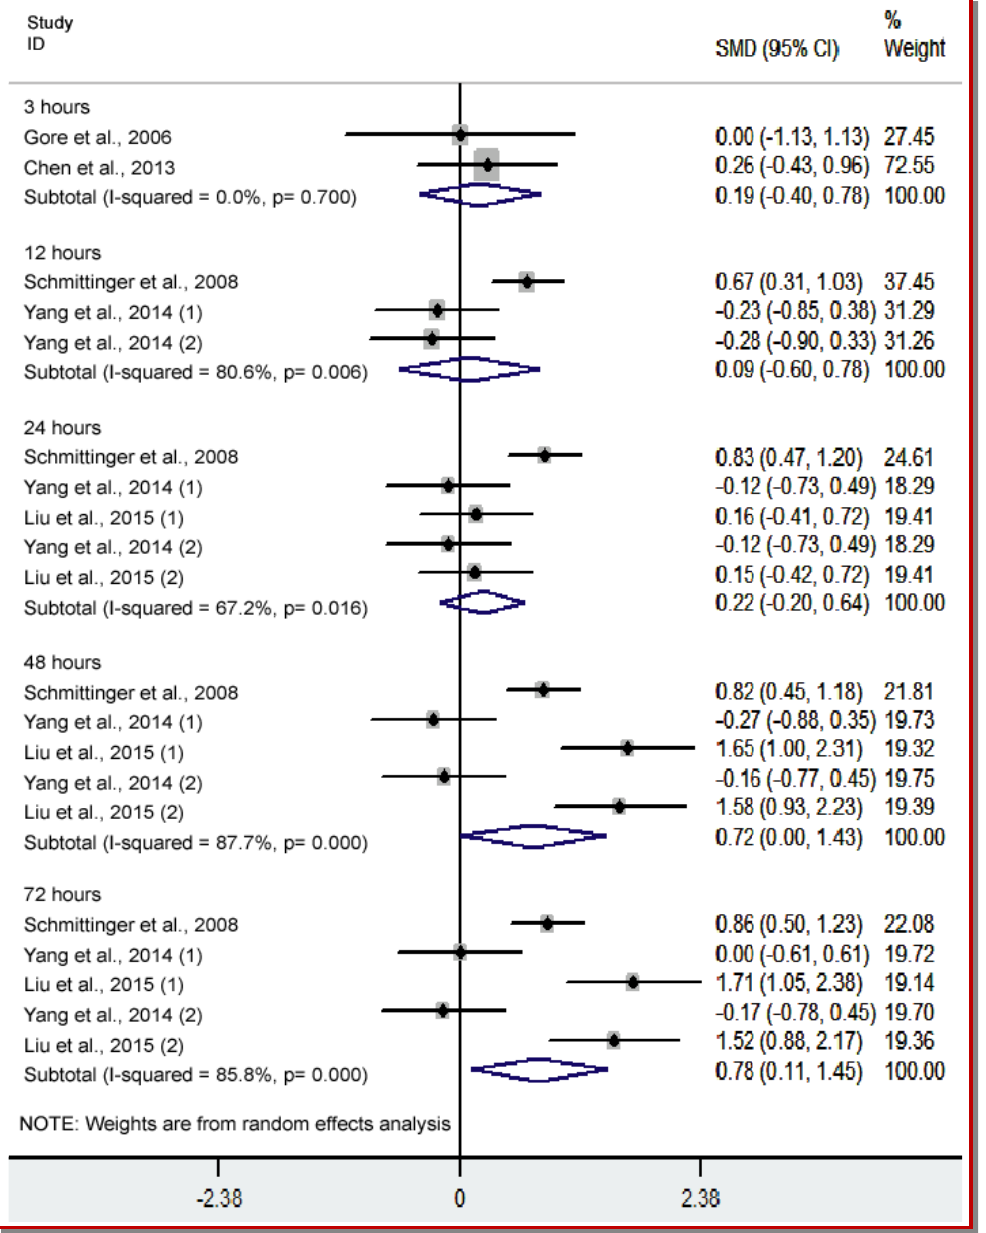
Figure 7: Meta-analysis of β -blocker on the stroke volume index (digit within the parenthesis means the number of studies for comparison) changes in central venous pressure, cardiac